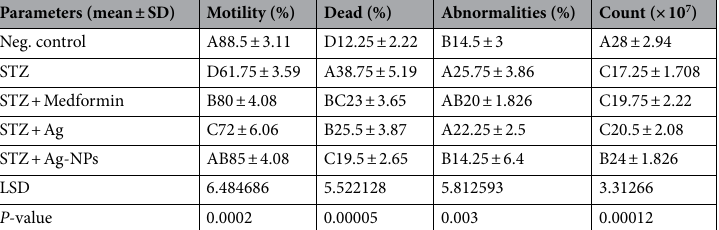
Parameters (mean ± SD) Motility (%) Dead